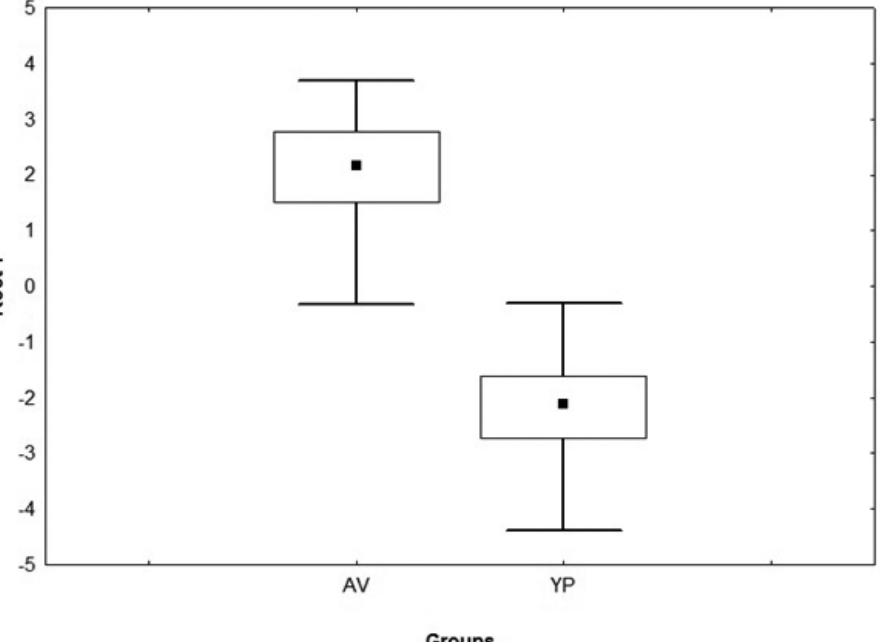
Figure 5. Box plot generated with the root 1 of GDA of morphological data for females. Rectangles: 25–75% from the data; squares: means. Boxplot stems represented 95% confidence